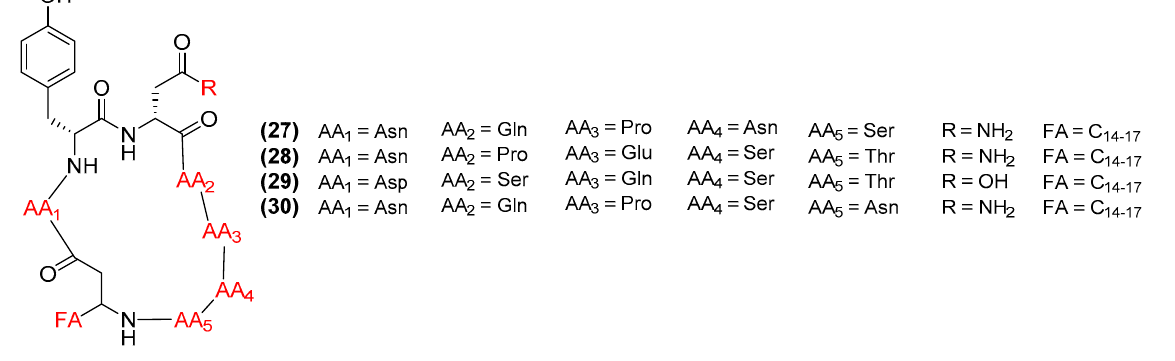
Figure 7. Chemical structures of iturin A ( 27 ), bacillomycin D ( 28 ), bacillomycin L ( 29 ), and mycosubtilin ( 30 ).